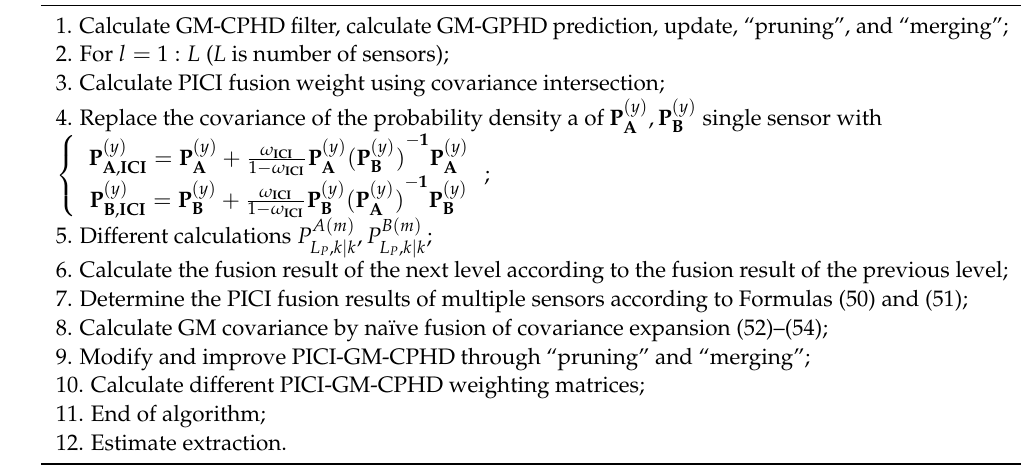
Algorithm 1: PICI-GM-CPHD filtering algorithm